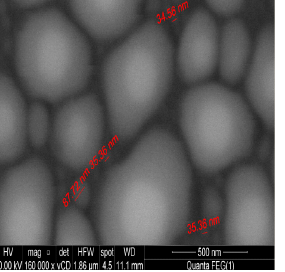
Table 3. The particle size measurements from FESEM and Scherer’s equation for thin films deposited on a glass substrate.